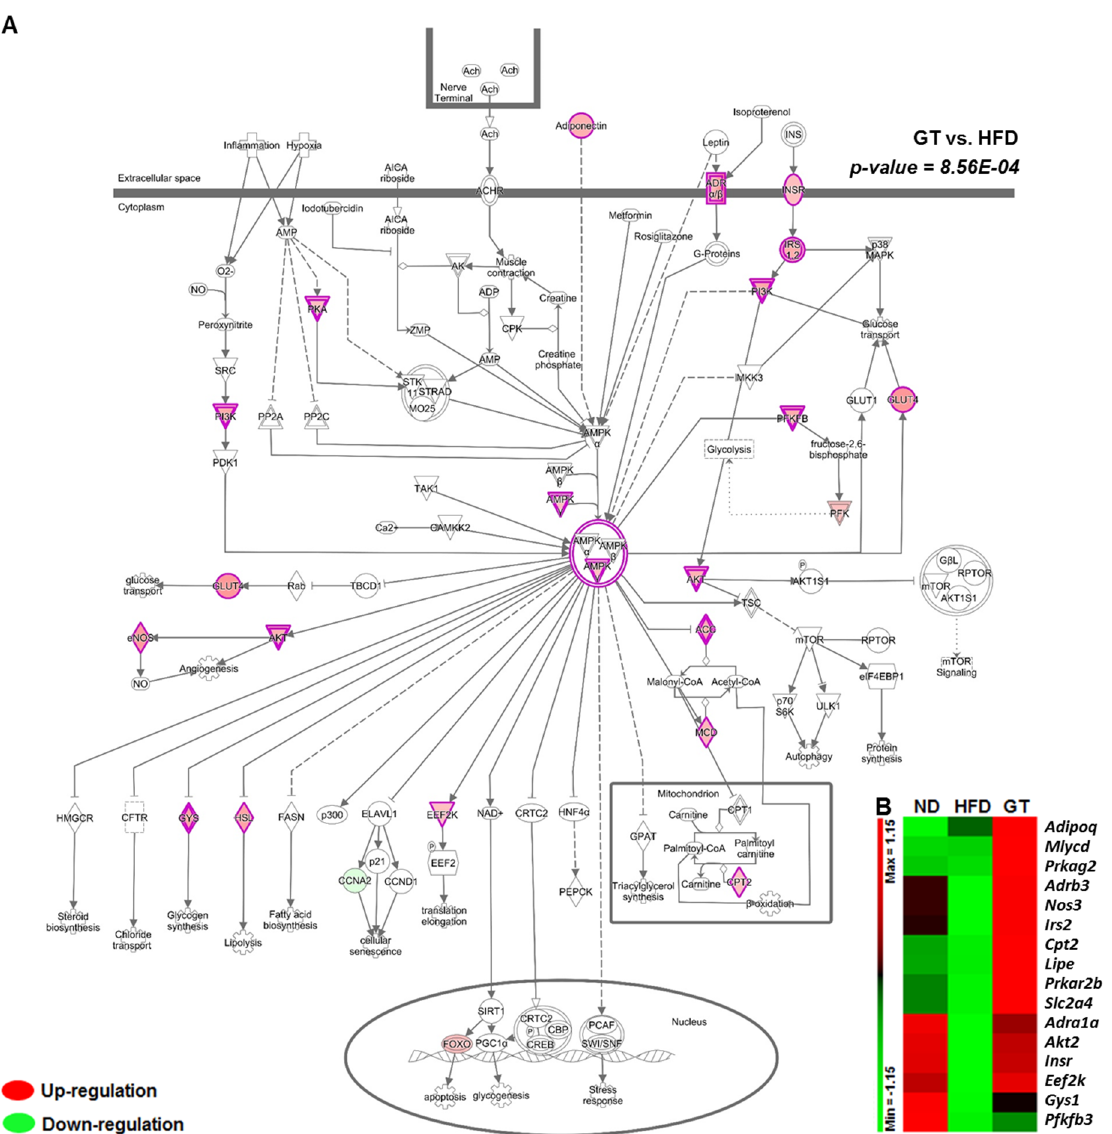
Figure 4. ( A ) Canonical pathway; and ( B ) heat map of the genes related to the AMP ‐ activated protein kinase (AMPK) signaling pathway in epididymal white adipose tissue (eWAT) of diet ‐ induced obese C57BL/6J mice treated with green tea extract for 12 weeks. ND, normal diet, AIN ‐ 93G; HFD, high ‐ fat diet, 60% kcal from fat; GT, green tea extract, 0.25% w / w . The significant pathways and functions were obtained via Ingenuity Pathway Analysis (IPA).